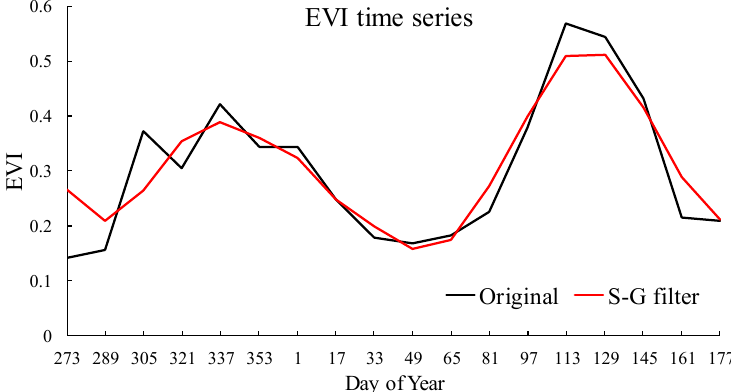
Figure 3. Enhanced vegetation index (EVI) time series before and after S–G filter smoothing.